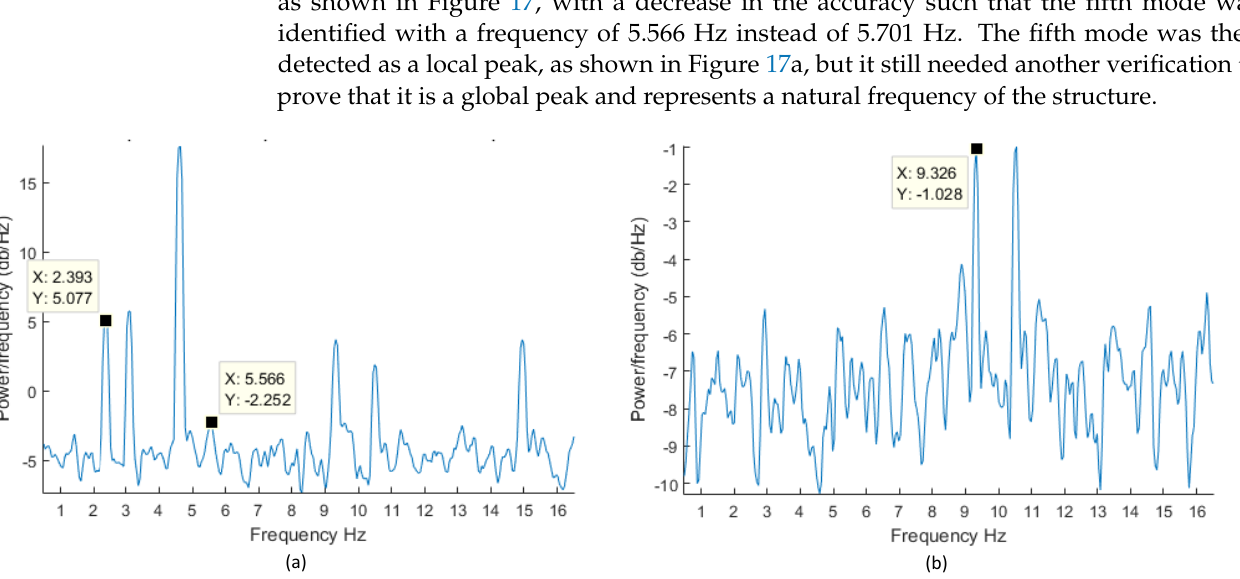
Figure 16. Estimated PSD of Sensor 1 of the noisy data. ( a ) Channel X. ( b ) Channel Z.